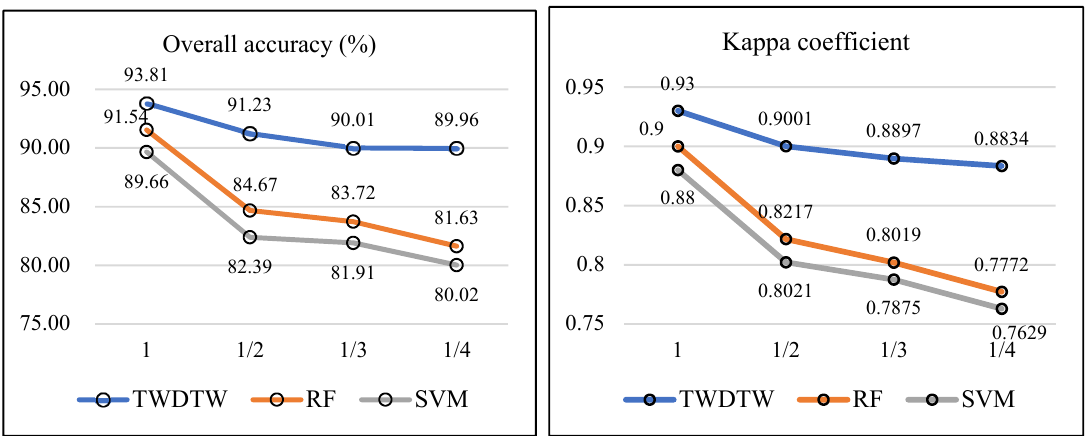
Figure 10. Overall accuracy (OA (%)) and kappa coefficient (KC) of TWDTW, SVM, and RF applied to the test area using 1/2, 1/3, and 1/4 of the training samples per class.